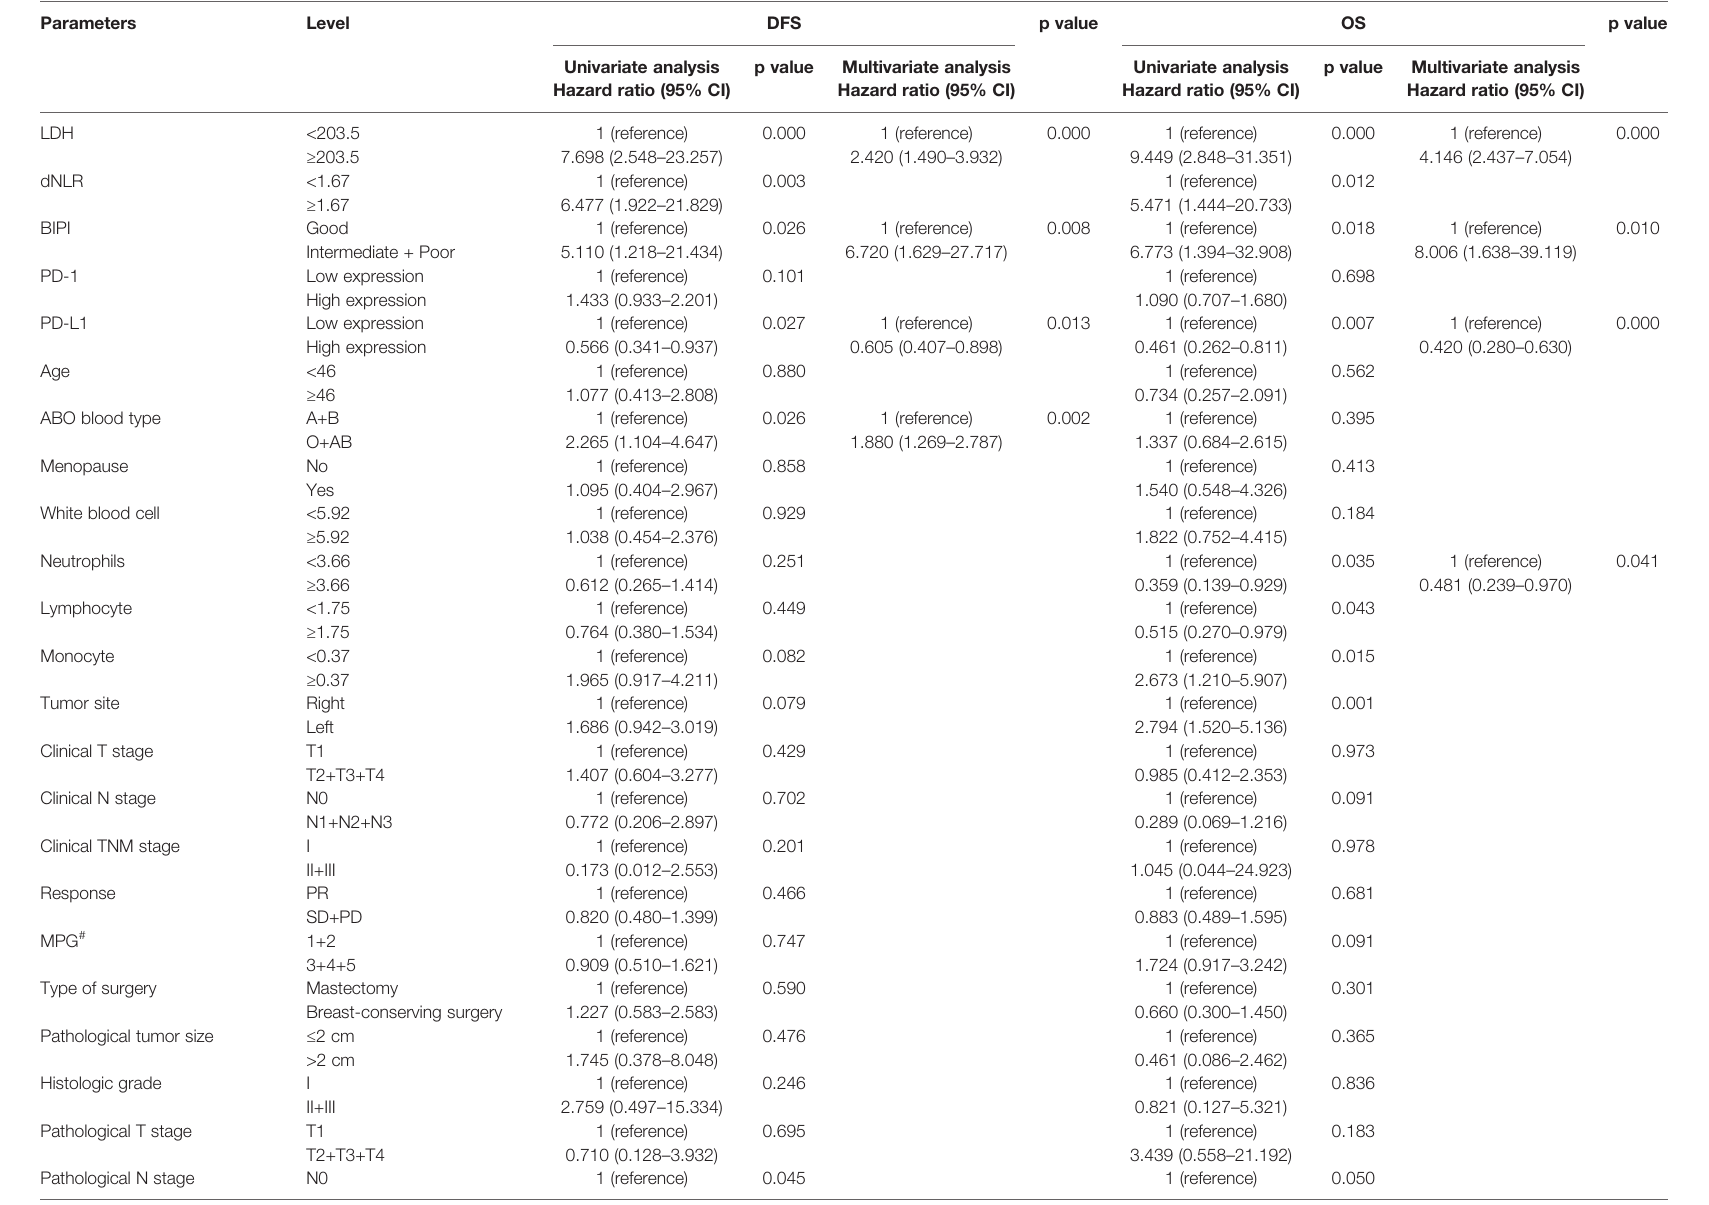
TABLE 5 | Univariate and multivariate cox proportional hazard regression model for disease-free survival (DFS) and overall survival (OS).